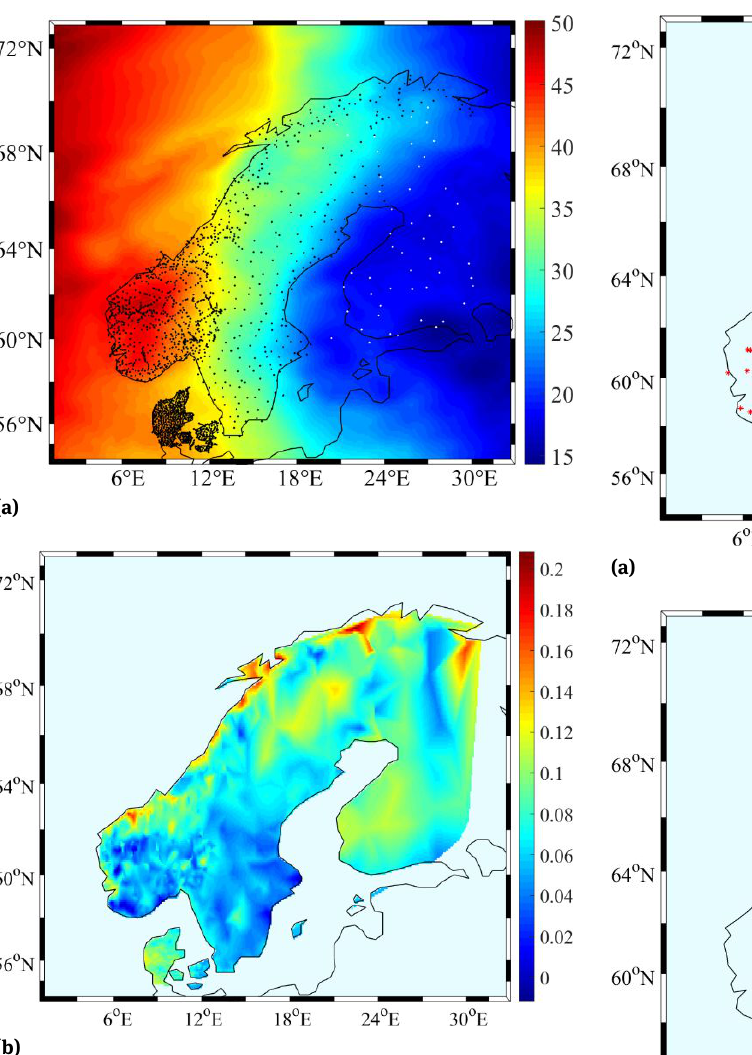
Fig. 1. a) Distribution of GL points over the Nordic countries on the background of NKG2015 geoid model, b) differences between the geoid heights and GL data (discrepancies) [m]